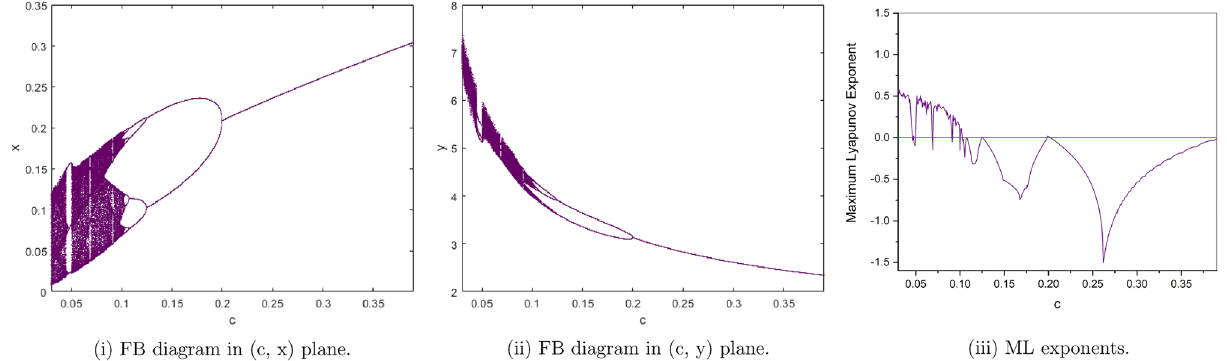
Figure 7. Bifurcation diagrams and ML exponents for the model (i) for values of a = 3, b = 2.5, e = 0.5, h = 1.022801547, c ϵ [0.03, 0.39].